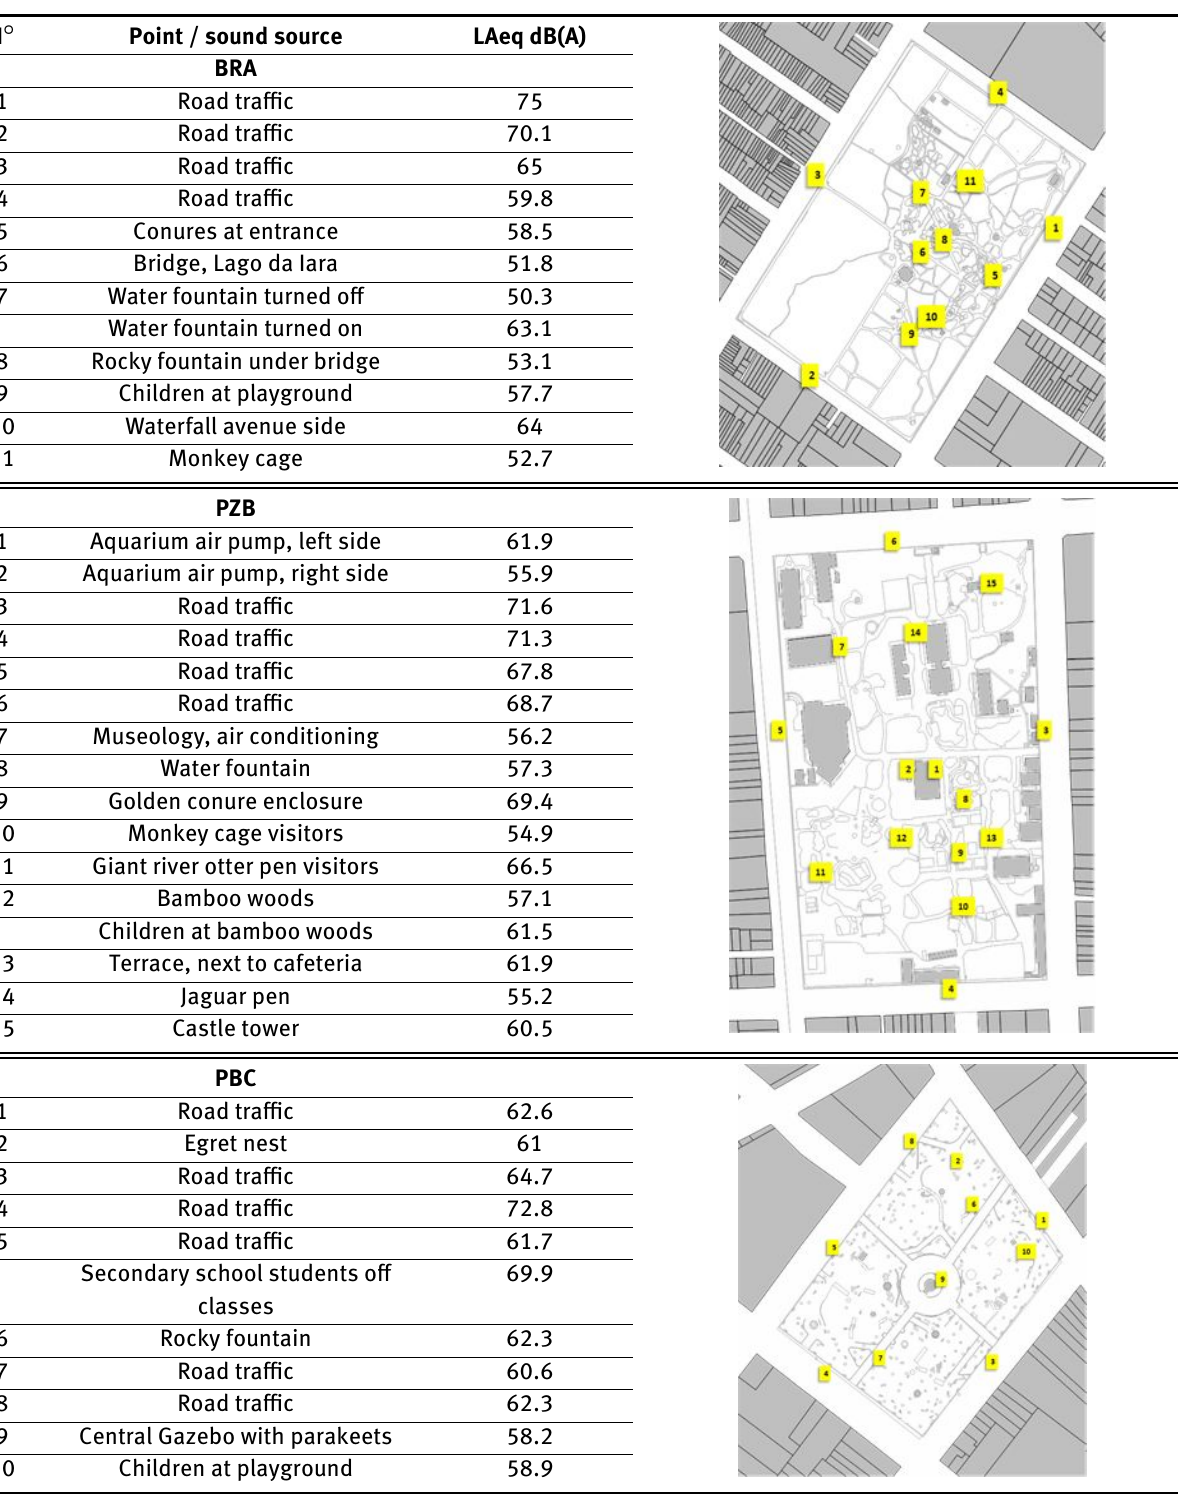
Table 1: Point / Sound sources in Belém